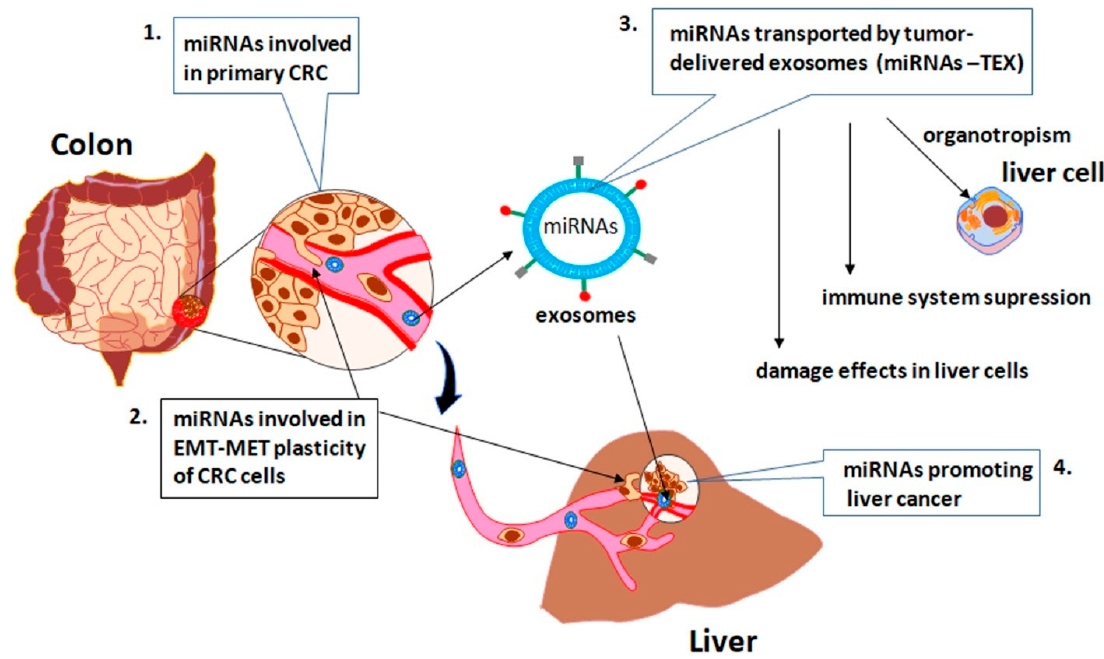
Figure 1. The PubMed string searches used to identify the specific miRNAs involved in colorectal cancer (CRC) development and progression as well as in liver metastasis.